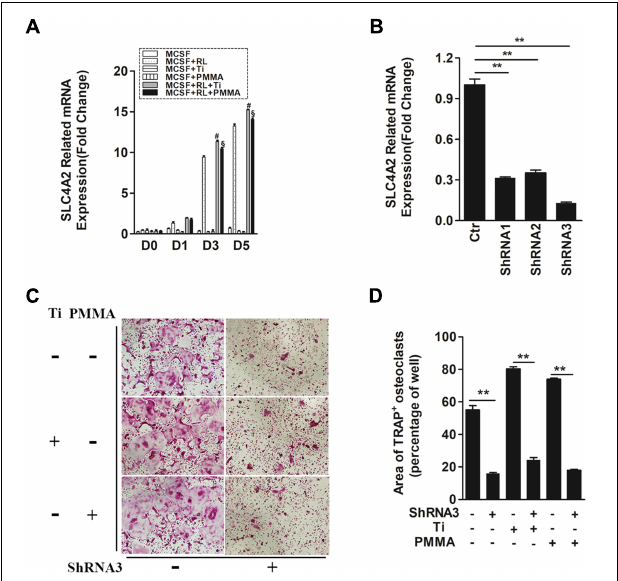
FIGURE 1 | SLC4A2 plays an important role in wear particle-induced osteoclastogenesis. (A) Up-regulation of Slc4a2 gene expression in the process of wear particle-induced osteoclastogenesis. Bone marrow-derived macrophages (BMM) were used [#, MCSF+RANKL(RL)+Ti vs. MCSF+RL, P < 0.01; §, MCSF+RL+PMMA vs. MCSF+RL, P < 0.01]. (B) Three different shRNA vectors targeting Slc4a2 , with shRNA3 yielding the greatest reduction in Slc4a2 mRNA. Effective knockdown of Slc4a2 in BMM cells, at 48 h after transfection using Slc4a2 shRNA1, shRNA2 and shRNA3, respectively. After transfection, cells were induced to differentiate into osteoclasts and harvested to examine Slc4a2 expression using reverse transcription quantitative PCR (RT-qPCR). (C) Effect of knockdown of Slc4a2 , using shRNA3, on wear particle-induced osteoclastogenesis in vitro . (D) The area of TRAP-positive cells, measured using ImageJ ( ∗ P < 0.05; ∗∗ P < 0.01). At least three independent replicated of each experiment were conducted